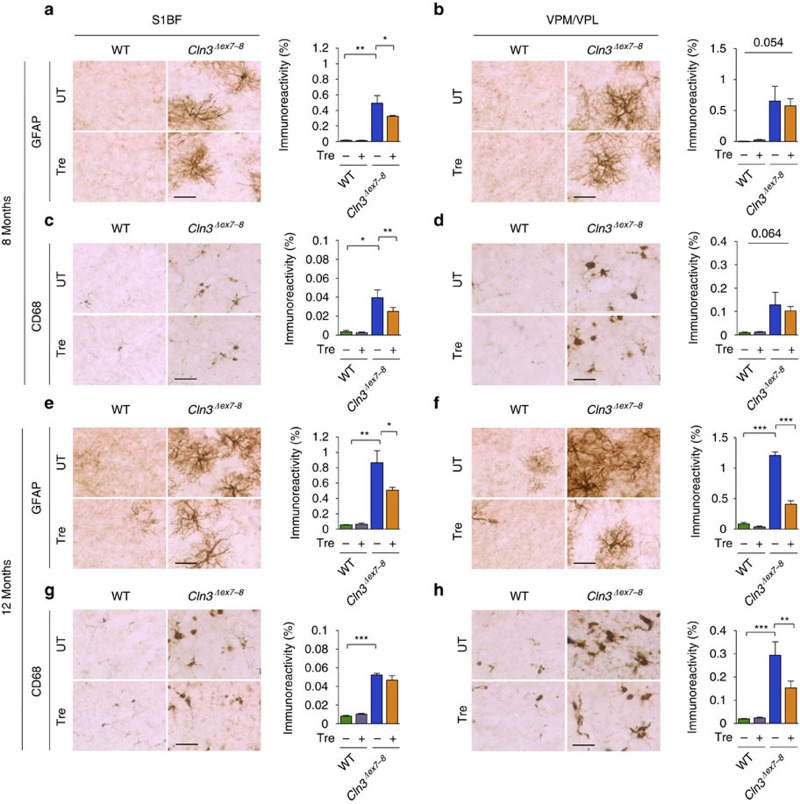
Assessment of neuroinflammation.(a,b) Analysis and quantification of astrocytosis in trehalose-treated (Tre) and untreated (UT) WT and Cln3Δex7-8 mice at 7 months of age using immunohistochemical staining for GFAP in the primary somatosensory cortex (S1BF; a) and in the interconnected thalamic relay nucleus (VPM/VPL; b). (c,d) Analysis and quantification of microglial activation using immunohistochemical staining for CD68 in the S1BF (c) and VPM/VPL (d) brain regions. Microglial activation is evident in both S1BF and VPM/VPL region of Cln3Δex7-8 mice, which is significantly rescued by trehalose treatment in the S1BF region. All groups of mice, n=4 or 5. (e,f) Analysis and quantification of astrocytosis in trehalose-treated (Tre) and control (UT) mice at 12 months of age using immunohistochemical staining for GFAP in the S1BF (e) and in the VPM/VPL (f). Trehalose treatment decreased GFAP immunoreactivity in Cln3Δex7-8 mice by 43% in the S1BF region and by 67% in the VPM/VPL region. (g,h) Analysis and quantification of microglial activation using immunohistochemical staining for CD68, in the S1BF (g) and VPM/VPL (h) brain regions. Microglial activation is evident in both S1BF and VPM/VPL region of Cln3Δex7-8 mice, which is reduced by 48% in the VPM/VPL region by trehalose treatment. All groups of mice, n=3 or 4. Scale bars, 50 μm. Data represent means±s.e.m. *P<0.05, **P<0.01, ***P<0.001.